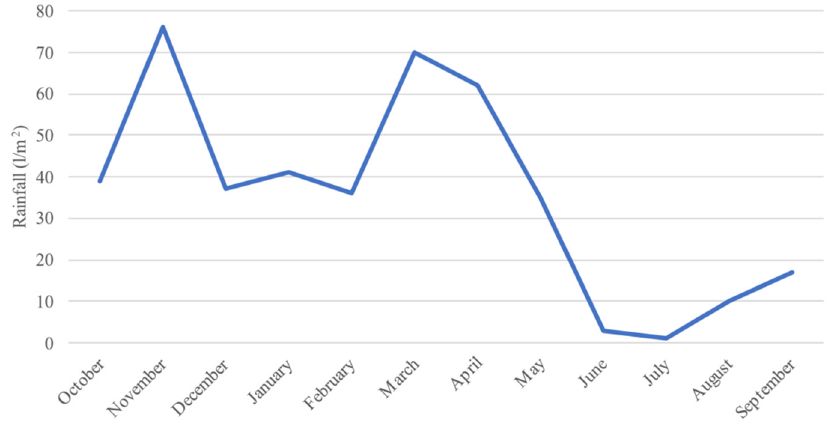
Figure 11. Annual rainfall distribution in Villacarrillo, Spain.